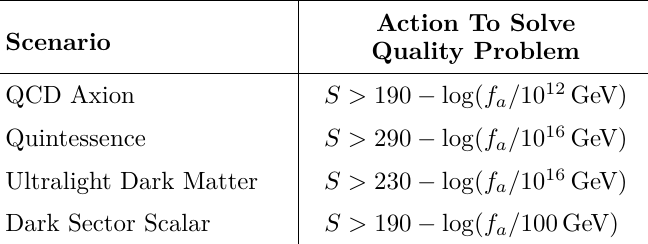
Table 2 . Required actions in order to solve the quality problem for different pseudo-Goldstone